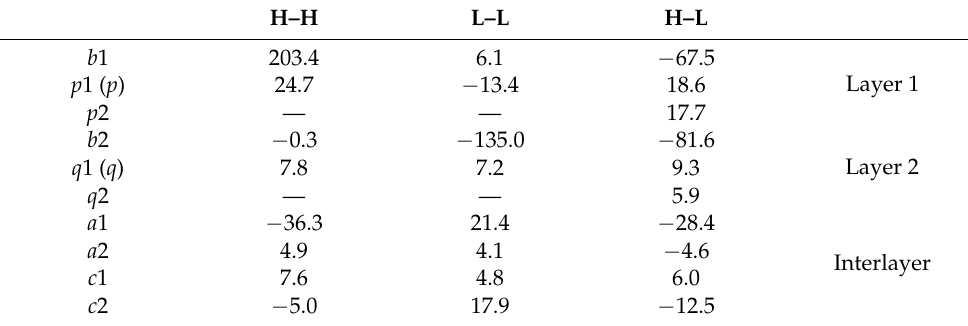
Table 4. HOMO–HOMO (H–H), LUMO–LUMO (L–L), and HOMO–LUMO (H–L) transfer integrals (meV) at 10.6 GPa (Structure A).